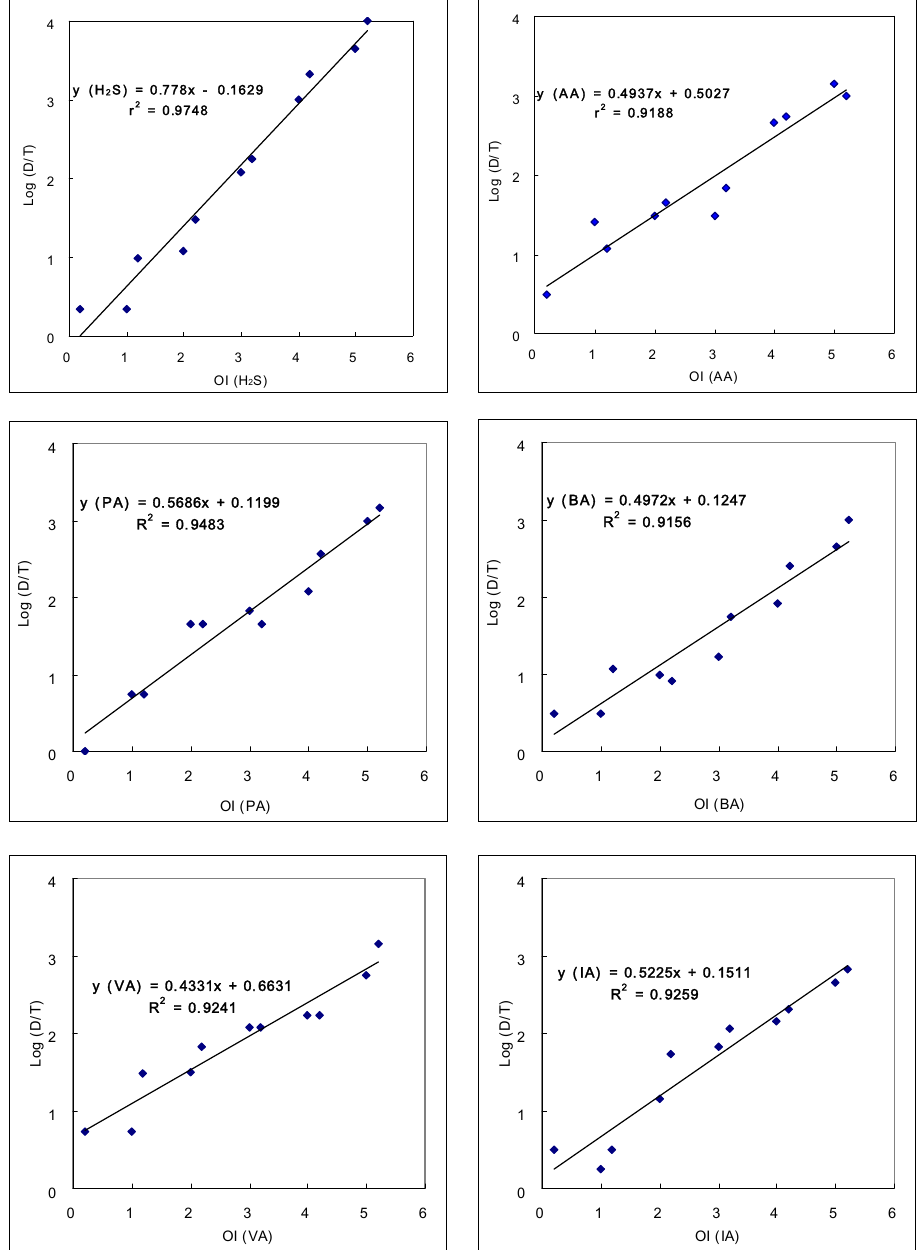
Figure 2. Relationship between odor intensity and dilution-to-threshold (D/T) ratio derived for six target